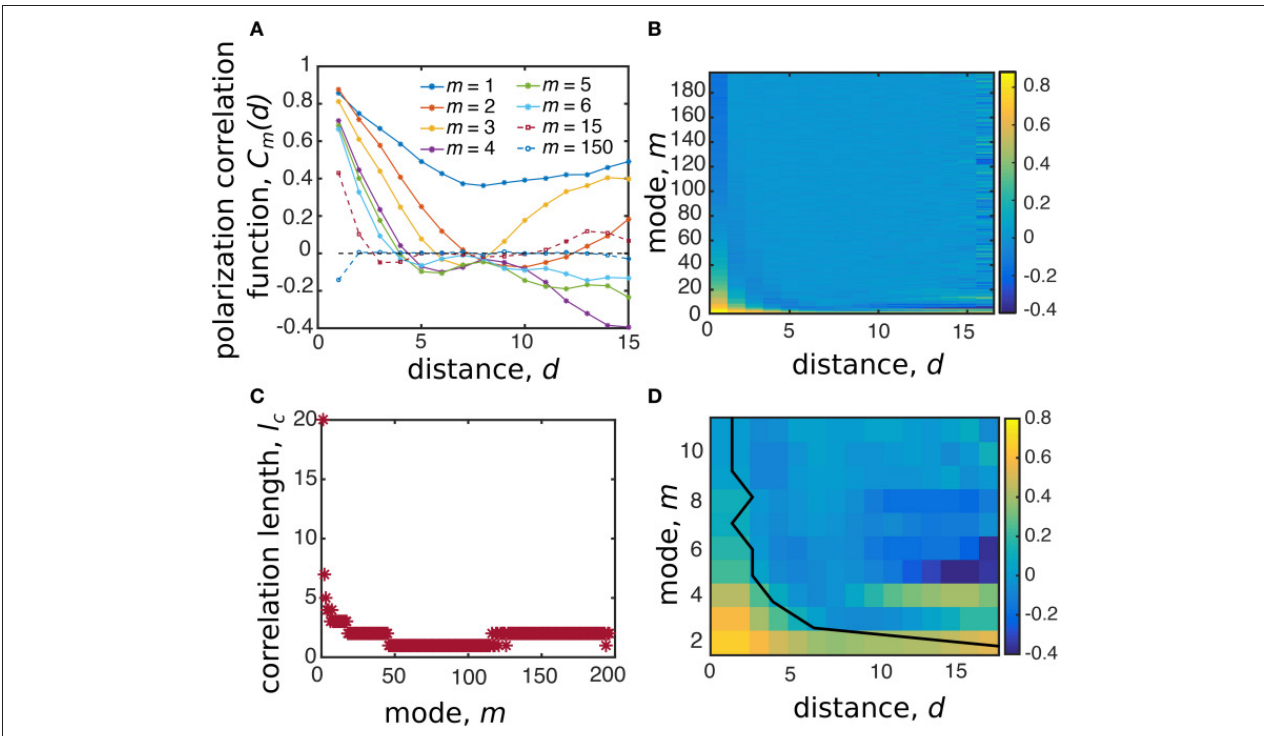
FIGURE 10 | The polarization correlation length identifies the m 1 mode as a pseudo-Goldstone mode. (A) The correlation function C m ( d ) for the mode polarization = fluctuations plotted against distance between particles d decays rapidly for modes m > 1, which can be seen in a heat map (B) for all modes. (C) The correlation length for all modes defined as the distance ℓ c where C m ( ℓ c ) 0. (D) Examining the first 12 modes as a heat map and superimposing the correlation length number = illustrates where C m ( d ) =